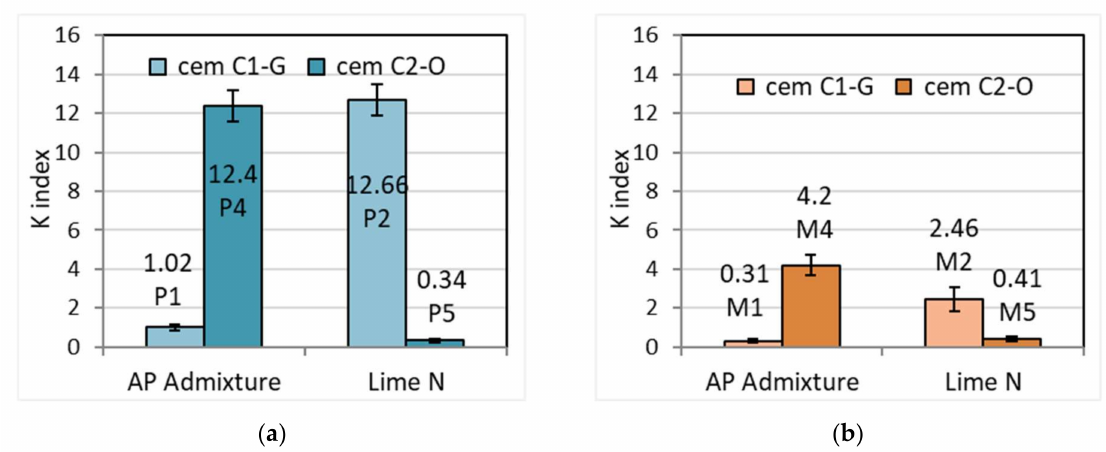
Figure 3. Index of susceptibility to segregation K for ( a ) plaster and ( b ) masonry mortars.